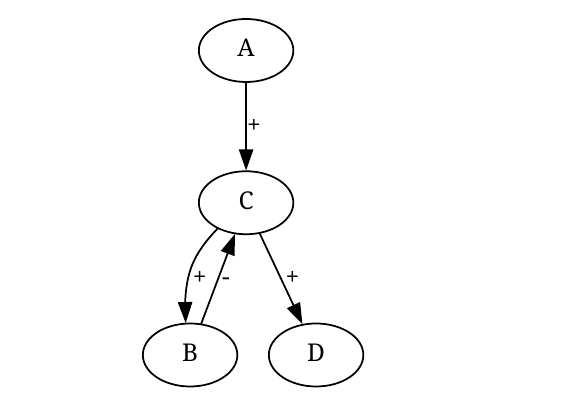
Figure 7 – Influence graph delimiting the ensembles of BNs in the